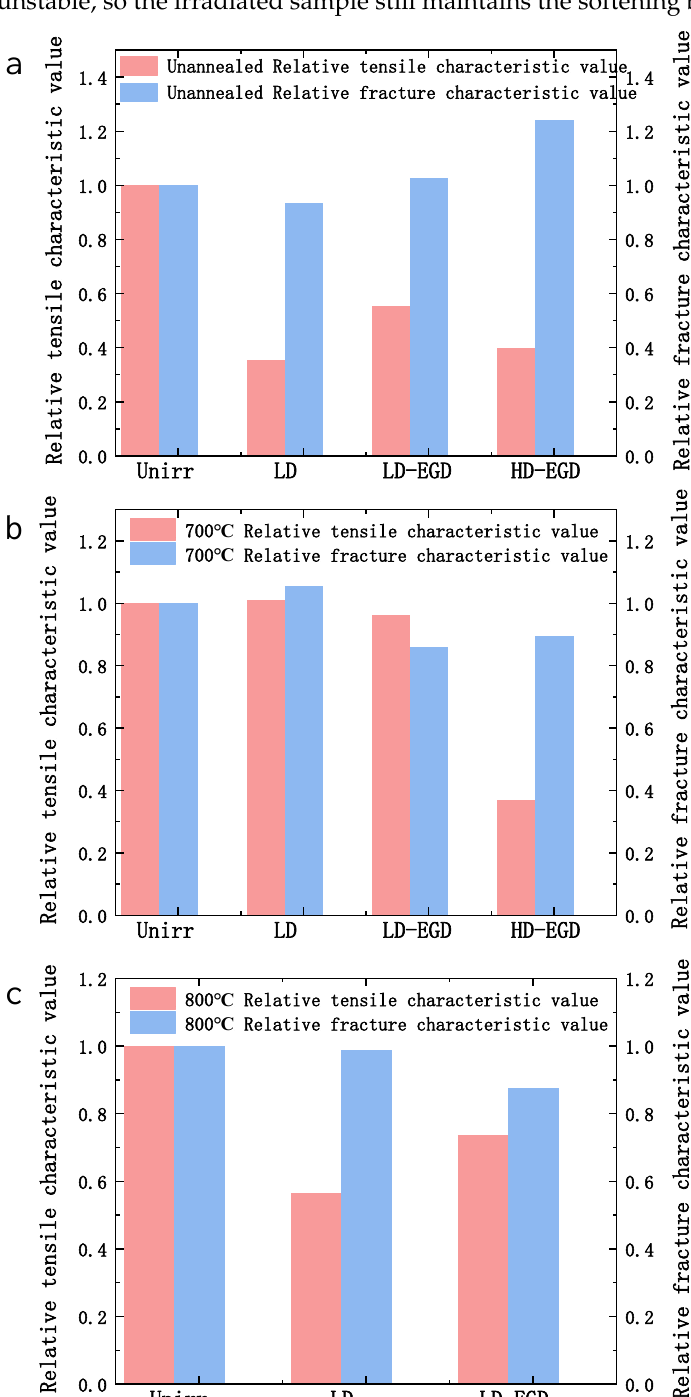
Figure 6. Changes in the characteristic values of tensile strength and fracture toughness of each sample under different annealing conditions:( a ) unannealed, ( b ) annealed at 700 ◦ C for 2 h, ( c ) annealed at 800 ◦ C for 2 h